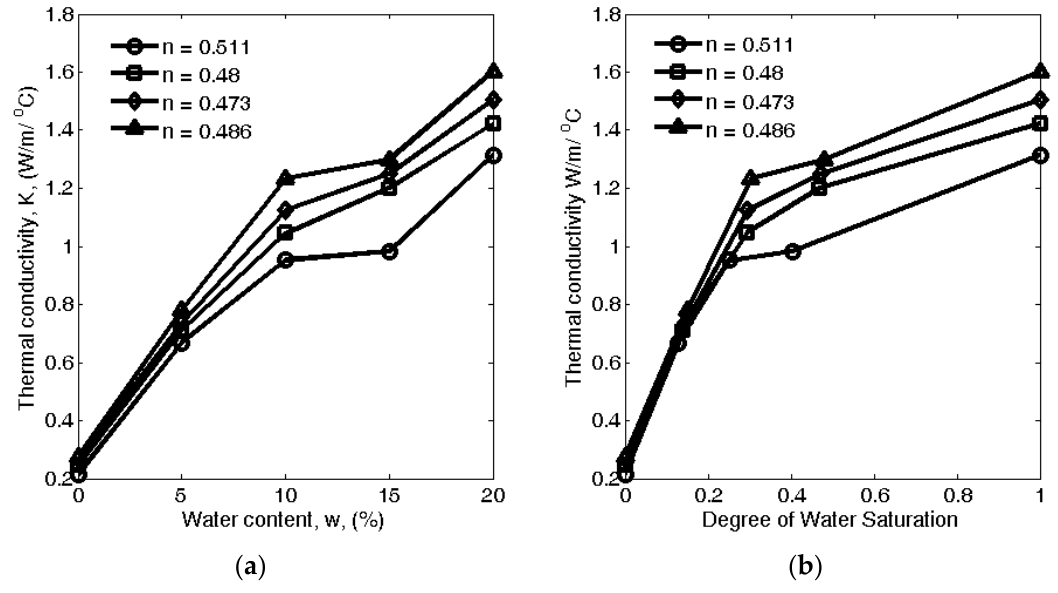
Figure 6. The thermal Conductivity vs. water content ( a ) and water saturation ( b ) at different porosities.